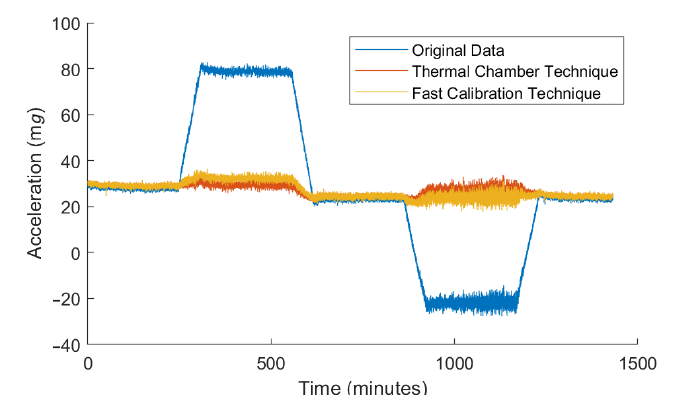
Figure 14. Thermal drift compensation with the parameters obtained in both cases.